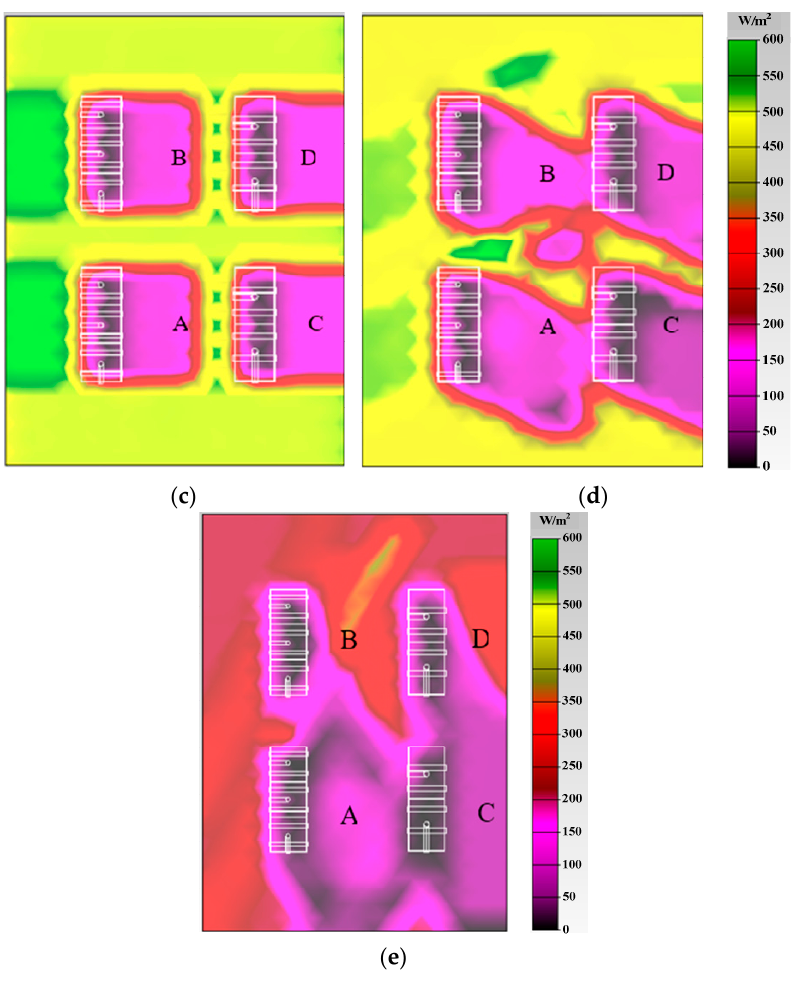
Figure 5. The irradiance distribution at the shadow areas of the building group: ( a ) at 8:00, ( b ) at 10:00,